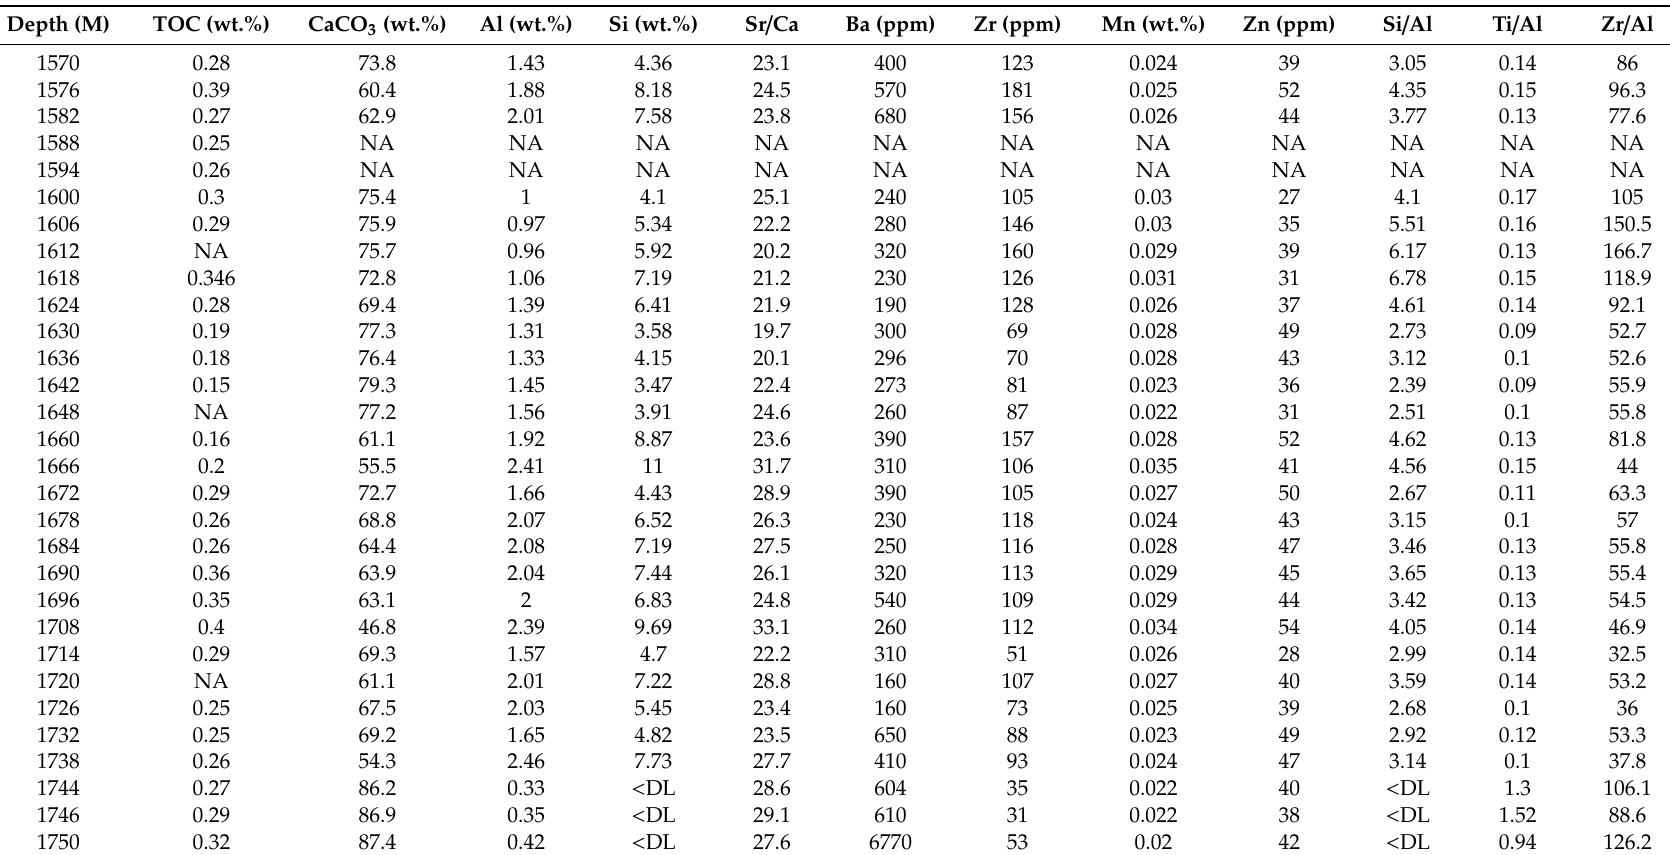
Table 2. Quantitative composition of total organic carbon (TOC), CaCO 3 , contents of specific major and trace elements and ratios of the studied succession from the BED 2-3 well. NA = not analyzed, < DL = below detection